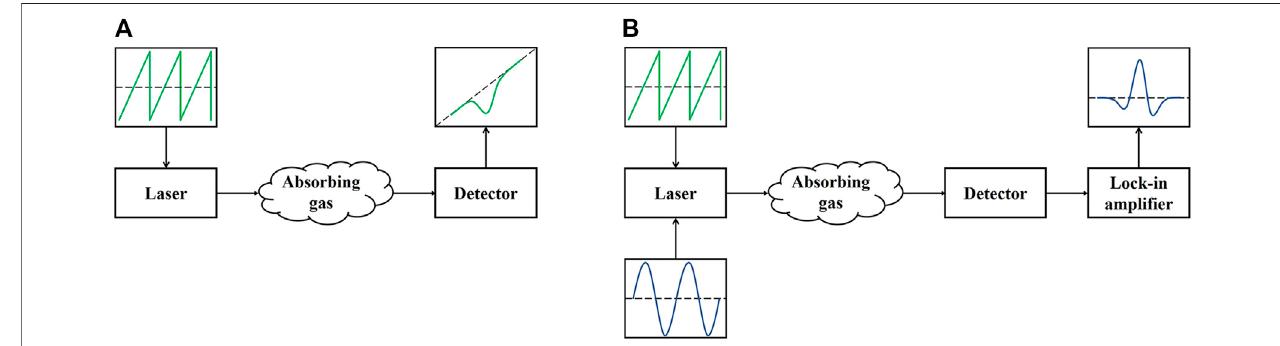
FIGURE 1 | (A) Scanned-wavelength direct absorption spectroscopy. (B) Scanned-wavelength modulation